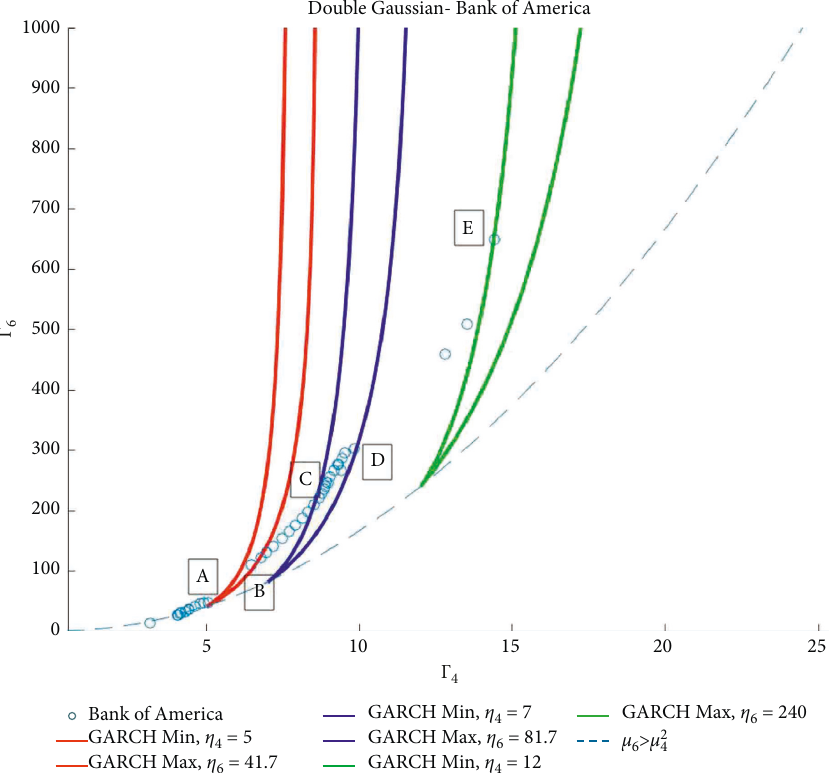
Figure 6: The phase diagrams for ( Γ , Γ ) space for GARCH-double-normal (1,1) models corresponding to different parameters given in 4 6 Table 2. We overlay the empirical data for Bank of America, truncated from 1% to 100% of the length of the time series, incremented in one percent steps, for the period of 6 October 2000 to 6 October 2018. To highlight the ability of the GARCH-double-normal model to fit higher order moments for specific lengths of time windows, we present three regions for the space that allow the fitting of the fourth- and sixth- order standardised moments by a GARCH-double-normal model. Each has a different time window that it can fit, shown by the letter, associated with Table 2. Table 2: Parameters of the conditional double Gaussian distributions used to construct “GARCHable” regions in Figure 6. Position η η 4 6 Leftmost (red) Centre (blue) Rightmost (green) The table summarises the parameters of the distributions used to model the time windows (A) to (B), (C) to (D), and from (E). These are the limits of the time windows in days that the particular instance of the double Gaussian distribution can be used to fit the higher order moments of the empirical data of the Bank of